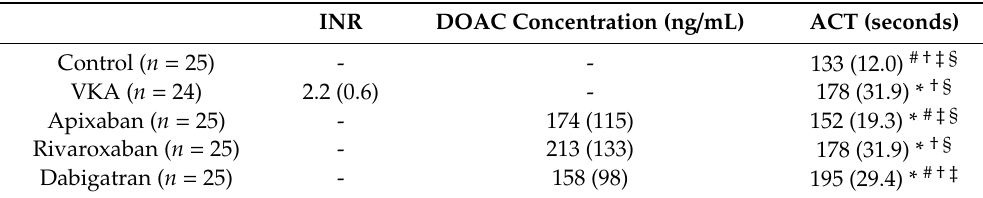
Table 1. Comparison of ACT and DOAC concentration between treatment groups.